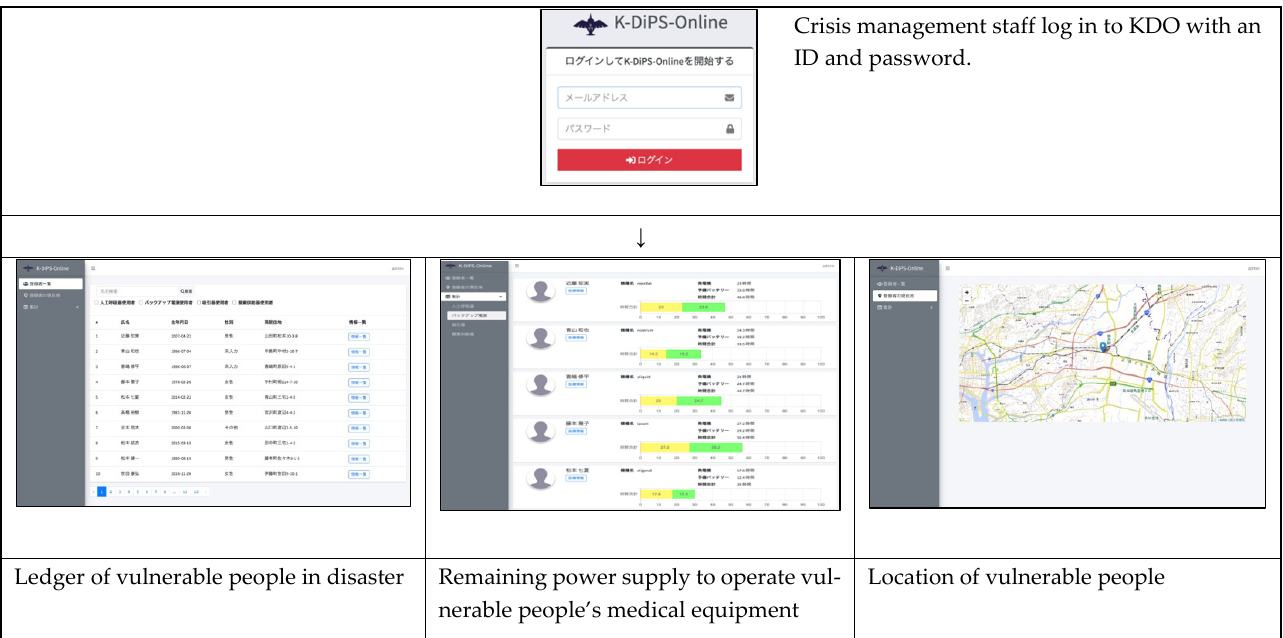
Figure 6. Screenshots of “Basic items,” “Supporters,” “ADL,” “Medical,” and “Vital signs” in KDS.